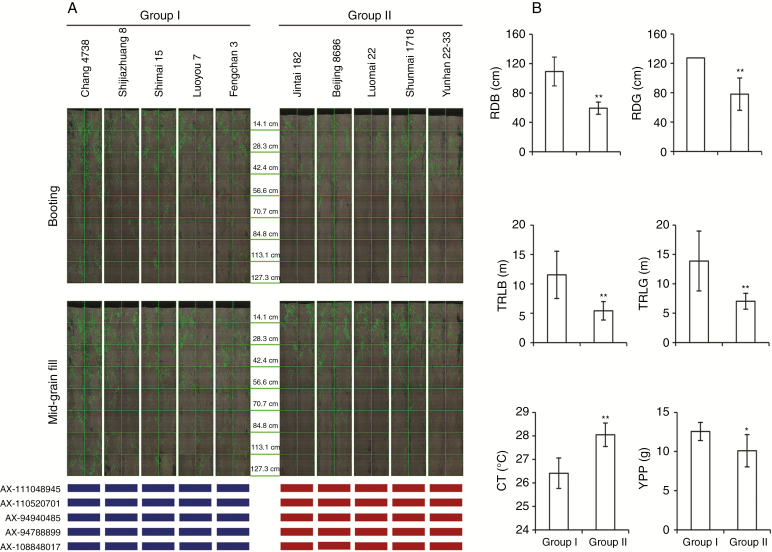
Comparison of root and shoot traits in the field between accessions with different marker alleles at peak SNPs in Co-6A, Co-6B and Co-6D by the minirhizotron system. (A) Minirhizotron scanning images. Group I consisted of five accessions with deep-root FMAs of all peak SNPs in Co-6A, Co-6B and Co-6D; Group II consisted of five accessions with alternative shallow root marker alleles in these peak SNPs. Blue rectangles indicate deep-root FMAs, red rectangles represent alternative marker alleles. (B) Comparisons of root depth at booting stage (RDB) and mid-grain fill stage (RDG), total root length at booting stage (TRLB) and mid-grain fill stage, canopy temperature (CT) and yield per plant (YPP) between Group I and Group II. *, ** significant differences at the 0.05 and 0.01 level, respectively; error bars denote the s.d.